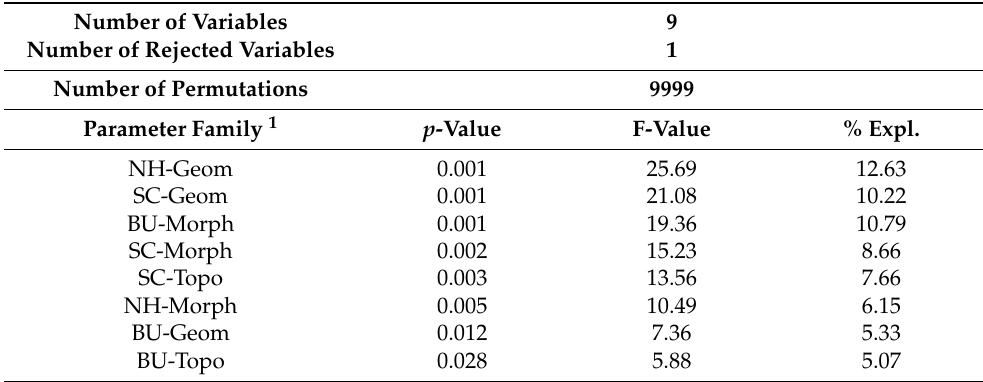
Table 4. Statistical parameters for the canonical correlation analysis (CCA) presented in Figure 3.